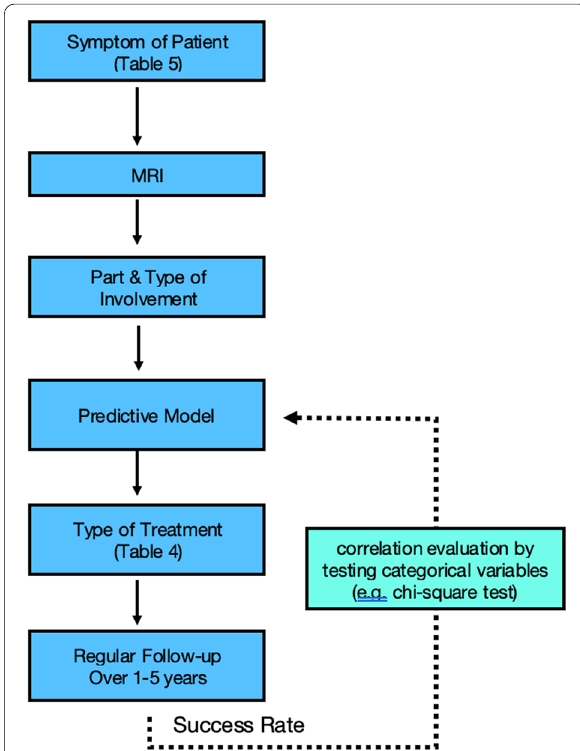
Fig. 8 Predictive algorithm for clinical pathways based on endometriosis sites